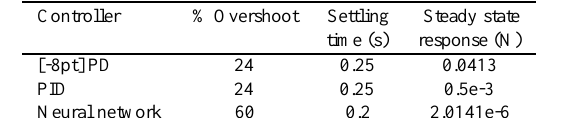
Table 3 Performance comparison of the three types of controllers